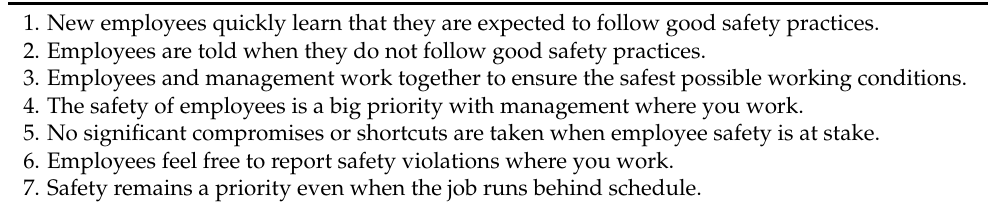
Table 1. Safety Climate Survey